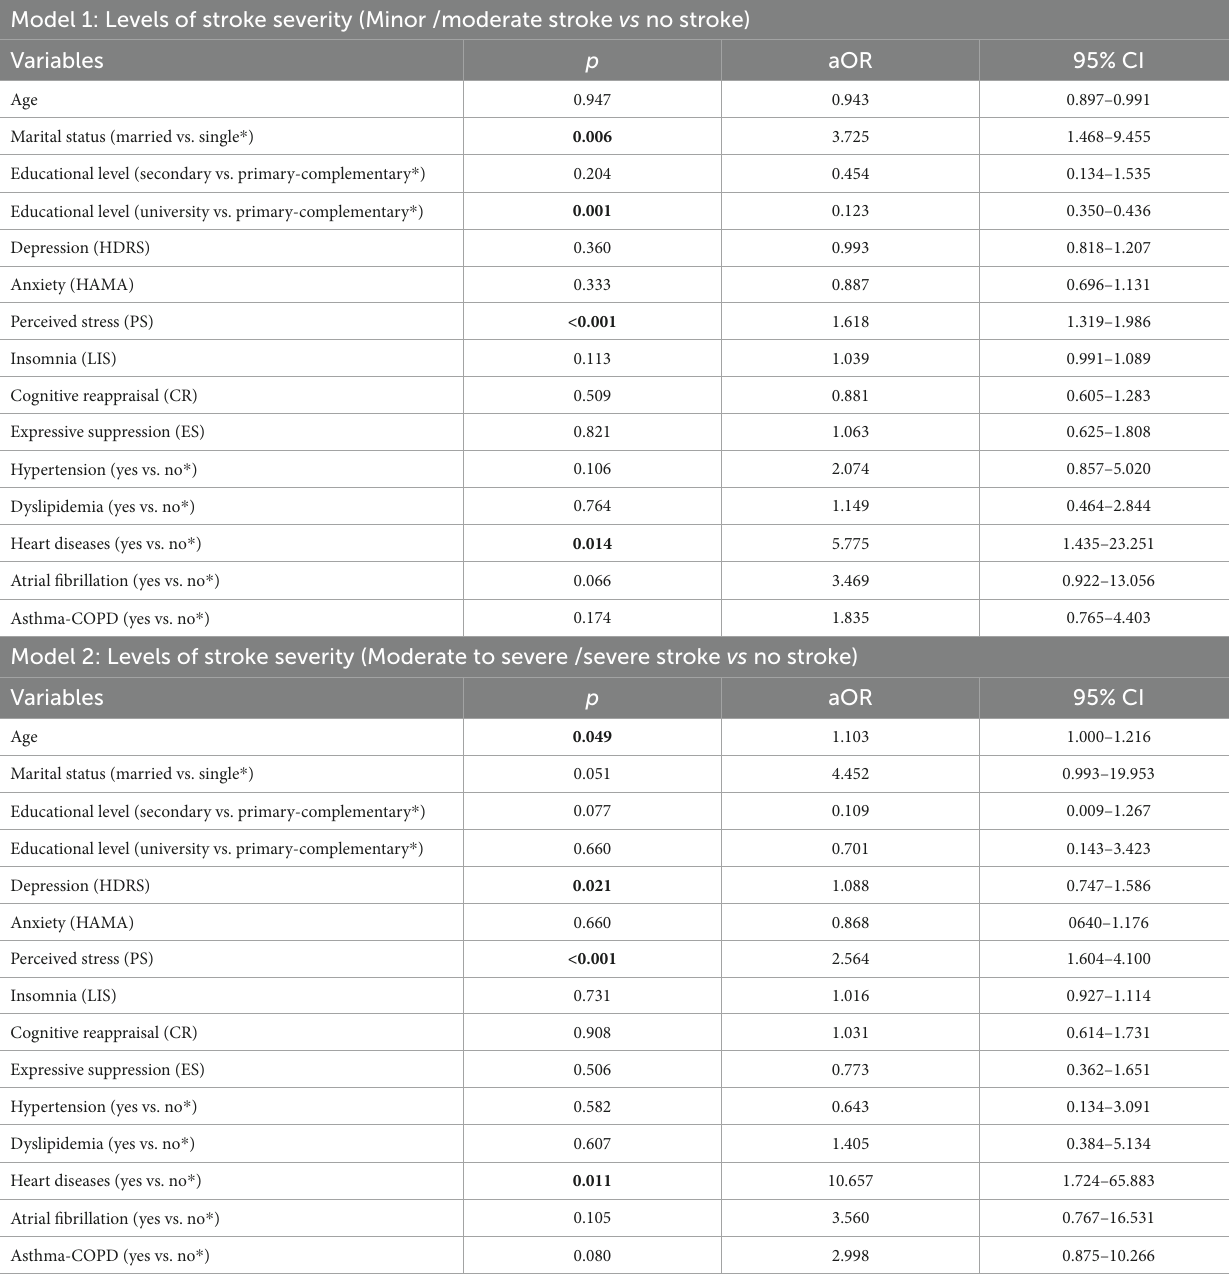
TABLE 6 Multivariable analysis: Multinomial regression taking the levels of stroke severity. Model 1: Levels of stroke severity (Minor /moderate stroke vs no